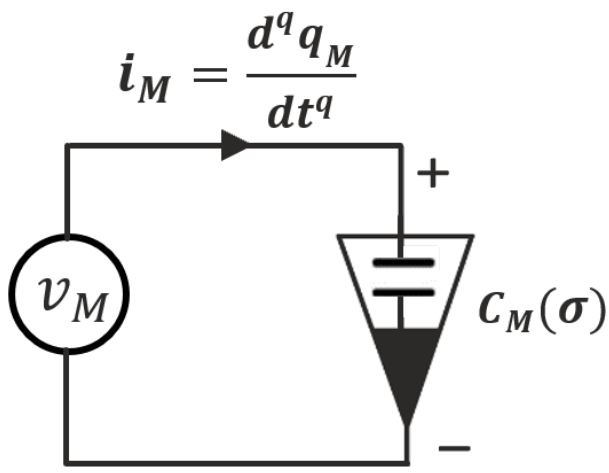
Figure 6. The symbolic layout of the fractional-order memristor.